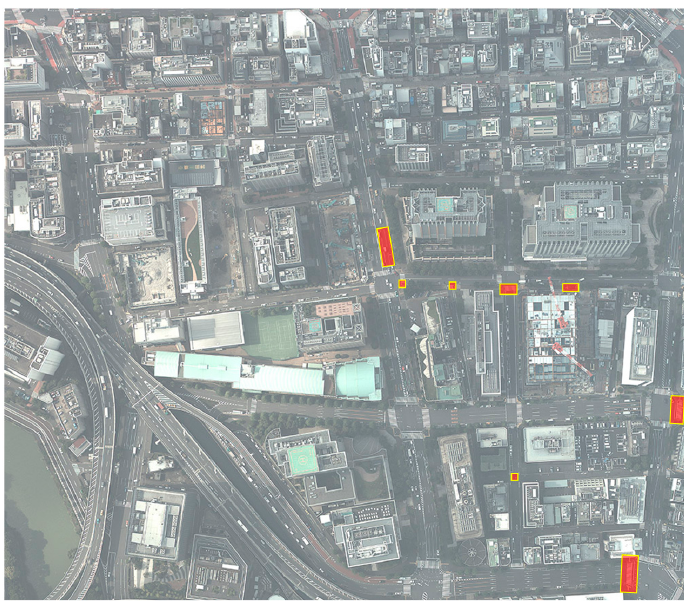
Figure 30. Areas where the road markings were repainted after 12 June 2014 (the date of the aerial image acquisition).